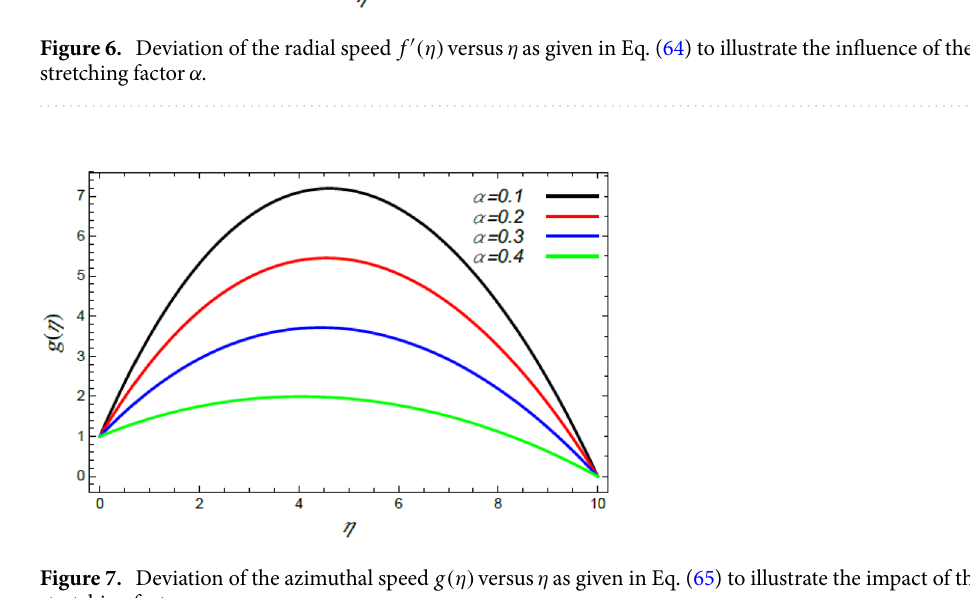
Figure 7. Deviation of the azimuthal speed g (η) versus η as given in Eq. (65) to illustrate the impact of the stretching factor α .